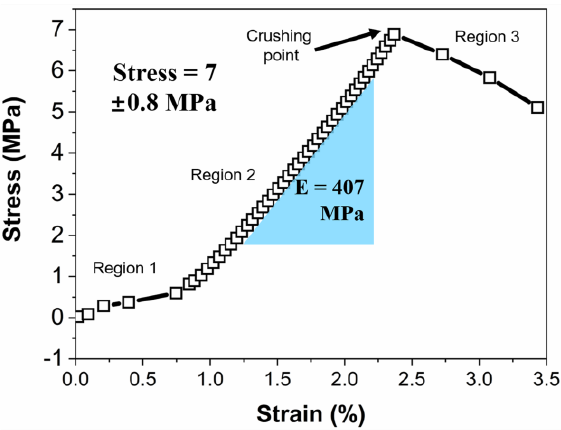
Figure 9. Compressive strain – stress curve of the SCB-S1 ceramic